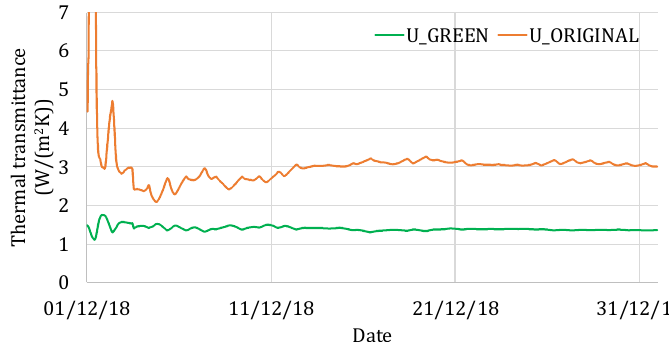
Figure 6. Green roof and original roof U-values.